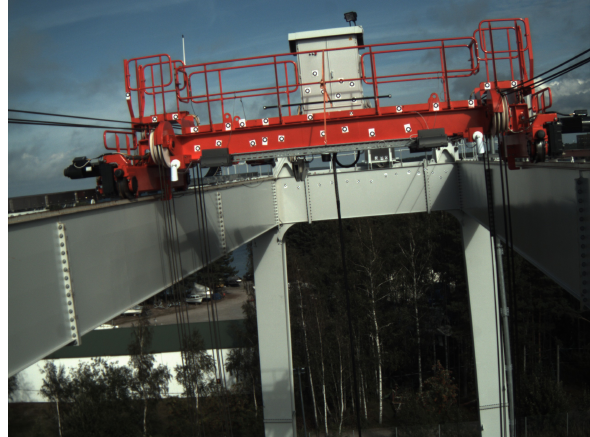
Figure 1: Frame and carriage of a crane to be